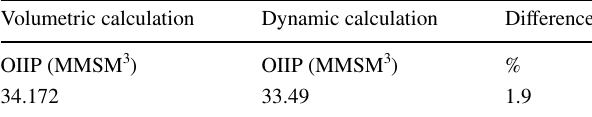
Table 2 Comparison between OIIP defined by volumetric method and dynamic